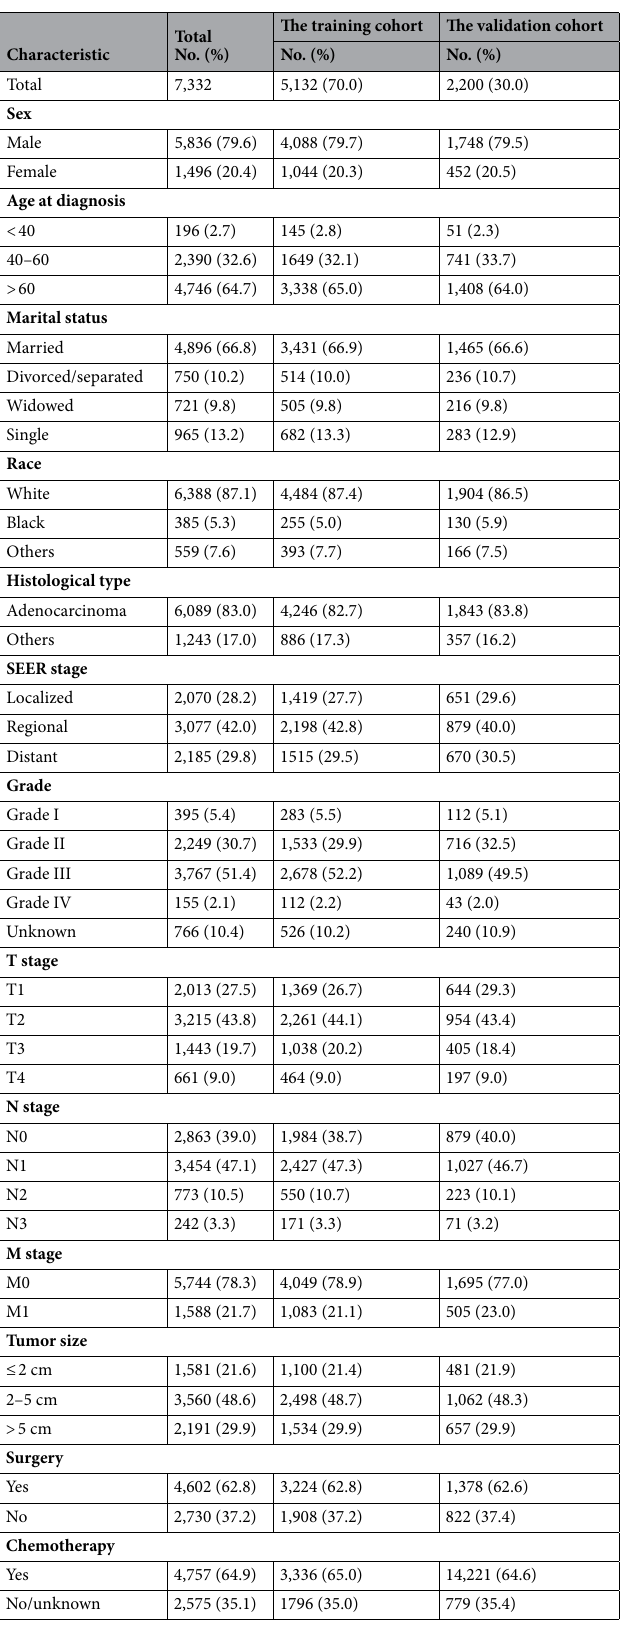
Table 1. Baseline demographic and clinical characteristics with gastric cardia cancer (GCC) patients in our study. Percentages may not total 100 because of rounding. SEER surveillance, epidemiology, and end